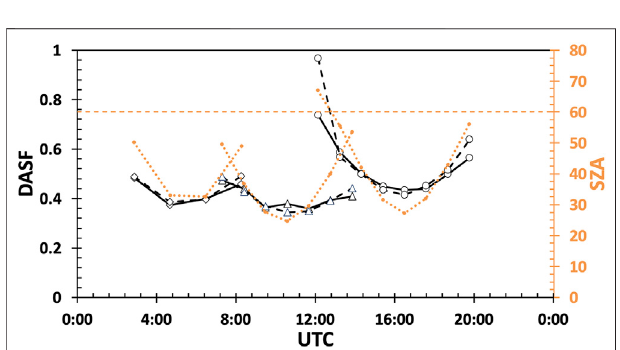
FIGURE 8 | Diurnal courses of monthly EPIC DASF (solid line), modeled DASF (dashed line) and SZA (dotted line) for region 3.2 in Southeast Asian (diamonds),Congo(triangles)andAmazonian(circles)forestson2017-02-24, 2018-06-14 and 2018-07-24, respectively. A SZA level of 60 0 is shown as a horizontal dashed line. NRMSE values for Southeast Asian, Congo and Amazonianforestsare3.9,3.6and16.3%,respectively.RMSEforAmazonian forests is 3.1% if SZA < 60 0